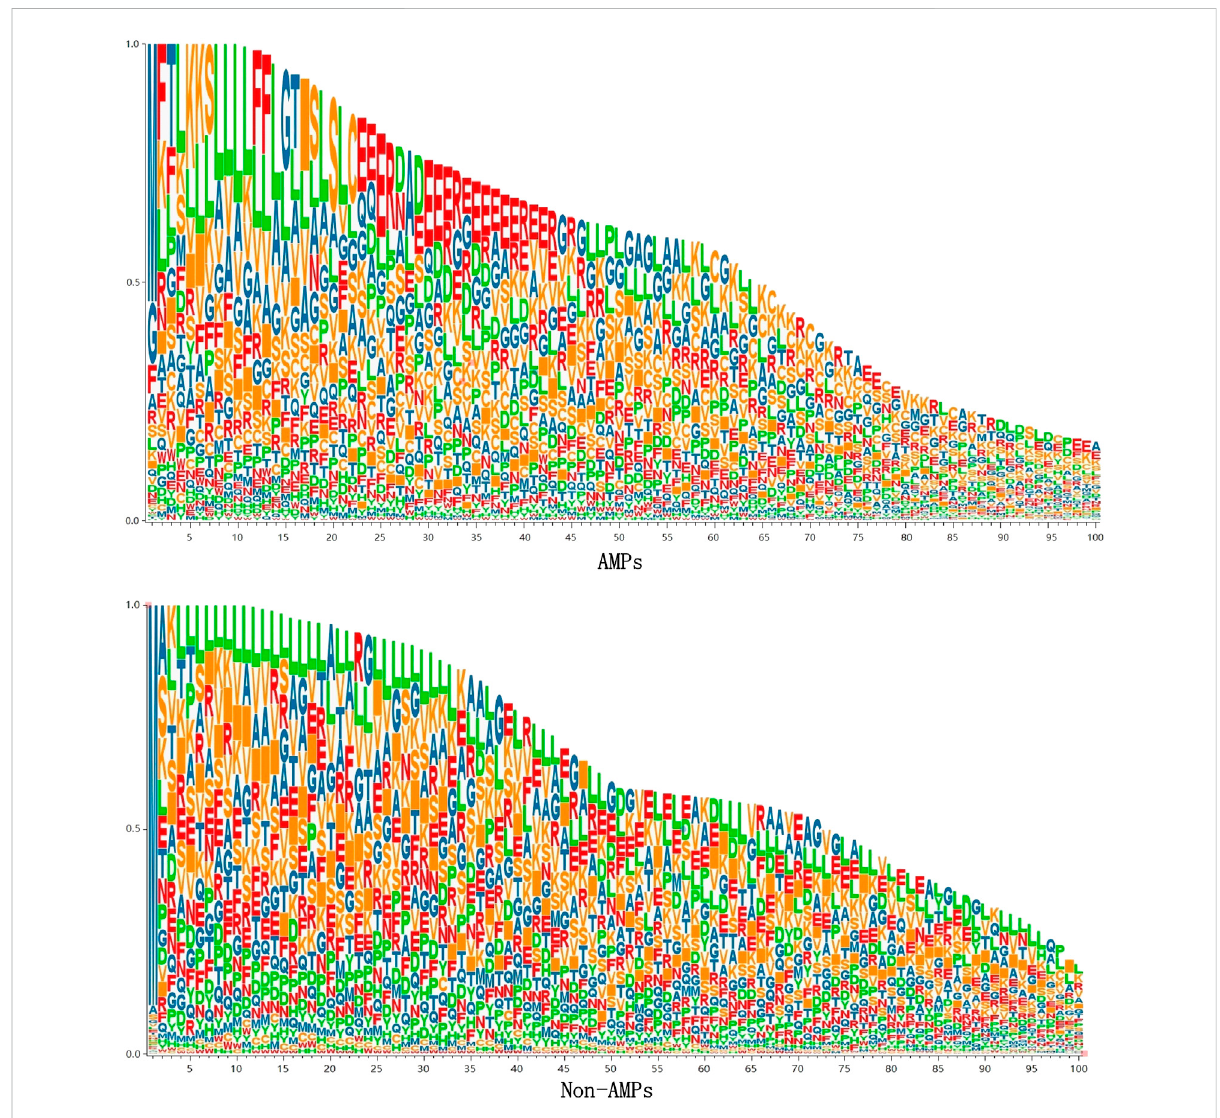
FIGURE 5 sequence logo